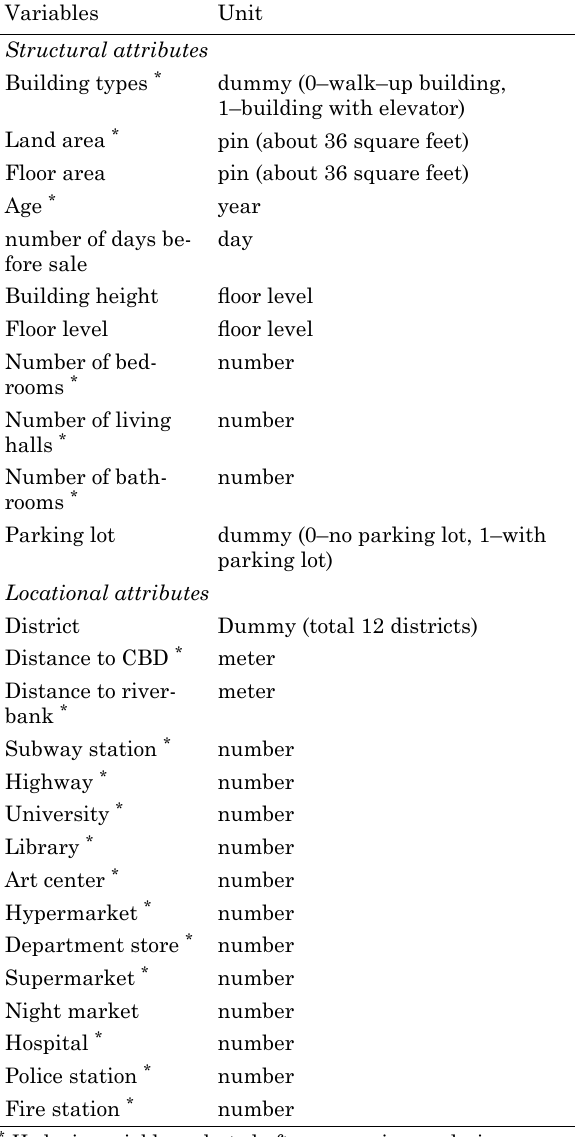
table 1. Variables used for structural and